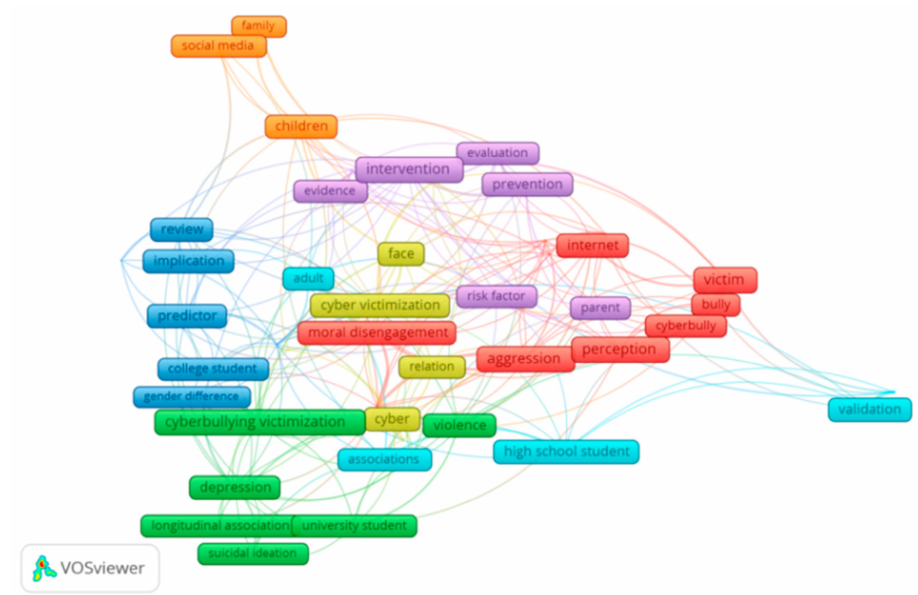
Figure 8. Coincidence of words in titles of publications on adolescent